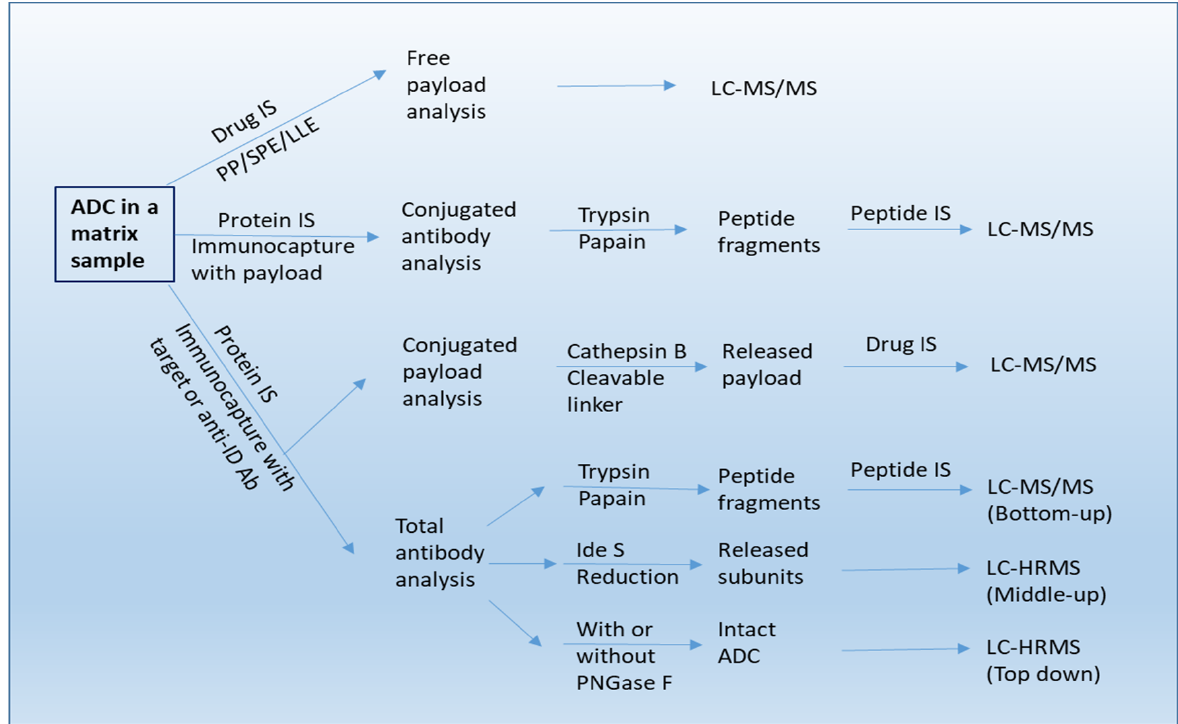
Figure 2. A workflow of bioanalysis for ADCs in biological sample using LC-MS/MS, LBA- A workflow of bioanalysis for ADCs in biological sample using LC-MS/MS, LC/MS/MS, and LBA-LC/HRMS methods. IS: internal standard. Anti-ID Ab: anti-idiotypic anti- LBA-LC/MS/MS, and LBA-LC/HRMS methods. body. idiotypic